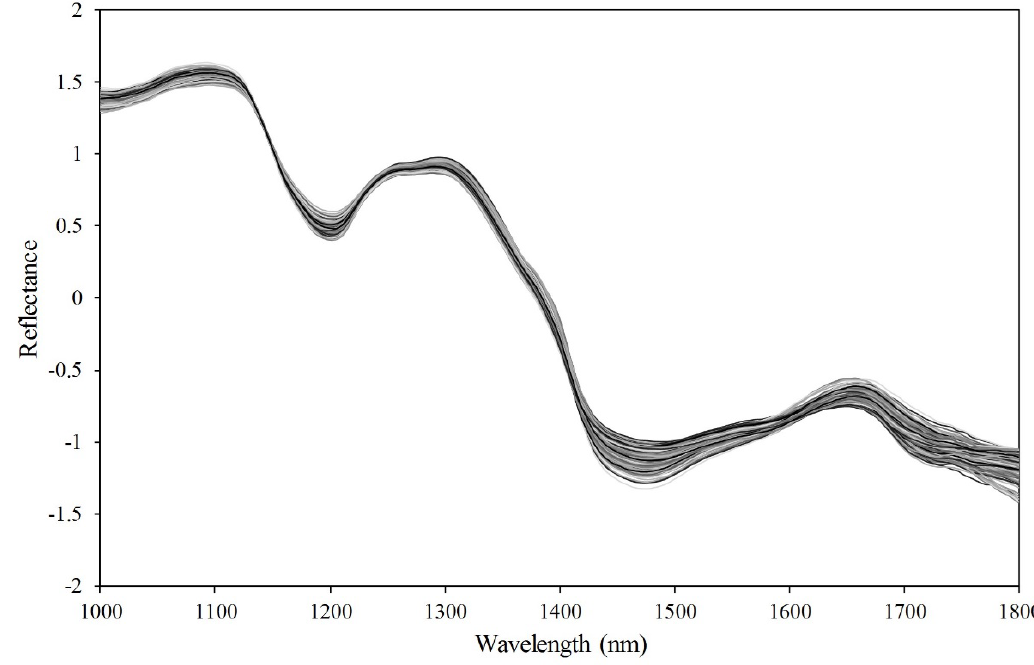
Figure 4. Average spectra of each soybean seeds in 1000–1800 nm.